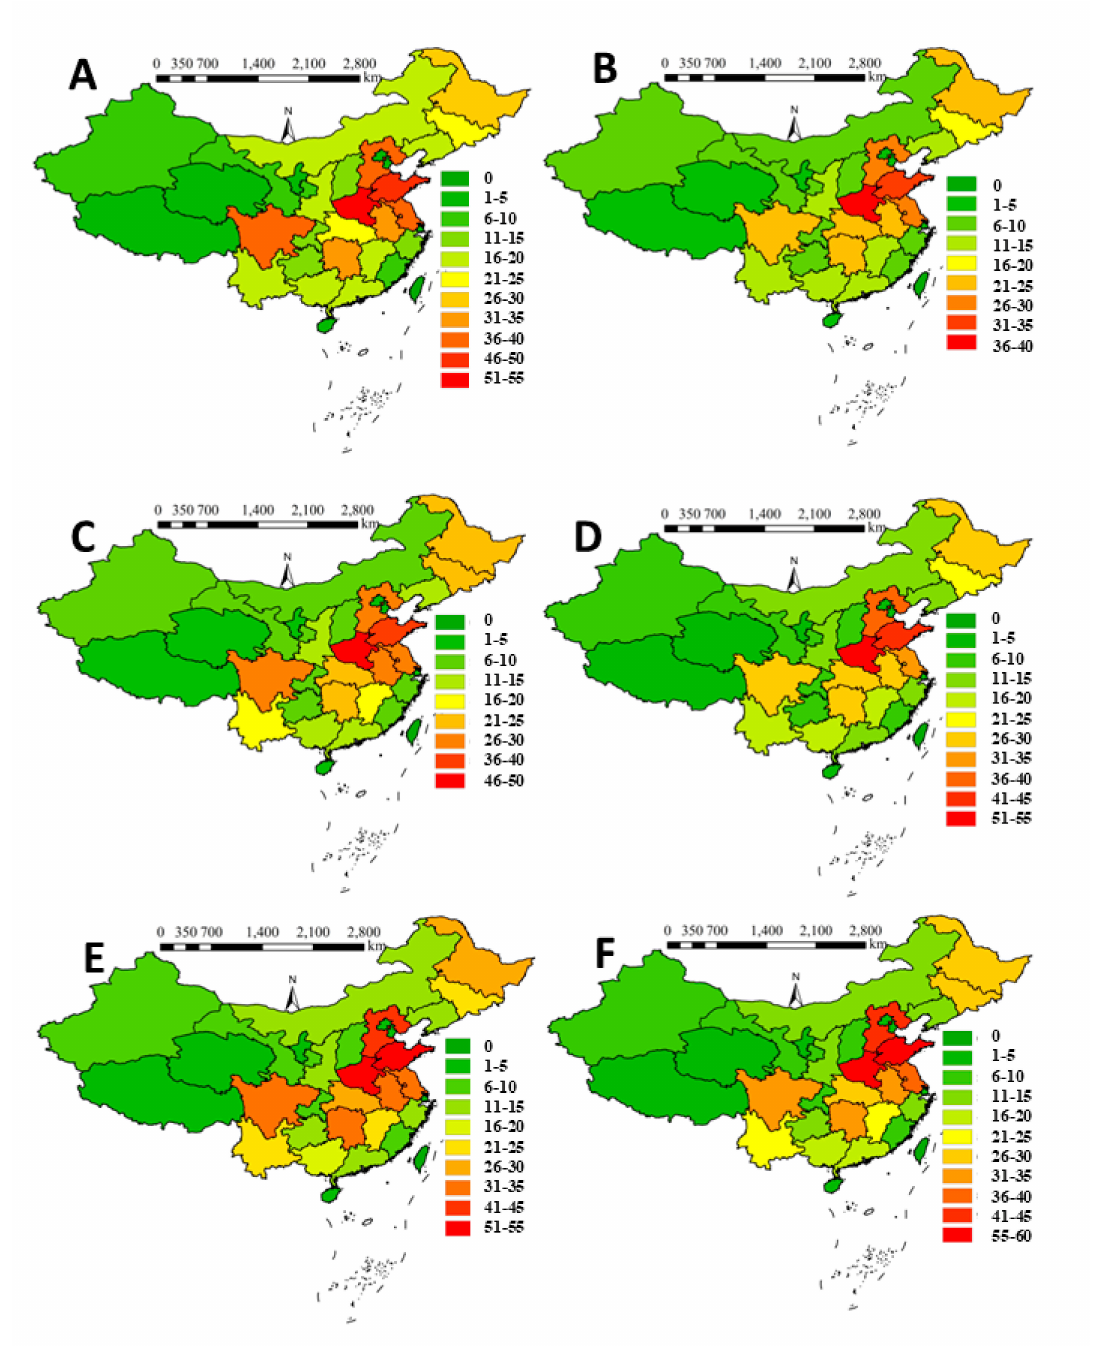
Figure 3. The spatial variation in cereal production (M t) in China from 1998 to 2016. Average cereal production from 1998–2001 ( A ), 2002–2004 ( B ), 2005–2007 ( C ), 2008–2010 ( D ), 2011–2013 ( E ), and 2014–2016 ( F